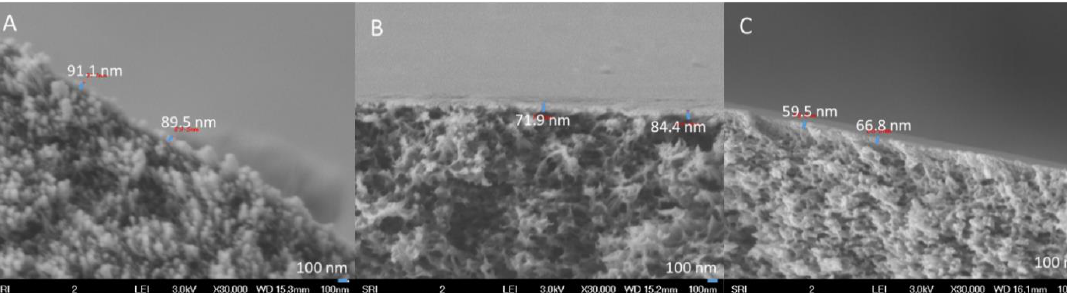
Figure 6 . SEM images of PBI HF outer barrier layers spun with air gaps of ( A ) 0.5″ (1.3 cm), ( B ) 2.5″ Figure 6. SEM images of PBI HF outer barrier layers spun with air gaps of ( A ) 0.5” (1.3 cm), ( B ) 2.5” (6.4 cm), and ( C ) 4″ (10.2 cm). (6.4 cm), and ( C ) 4” (10.2